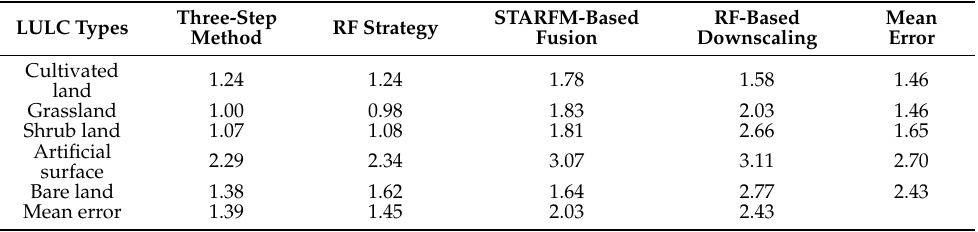
Table 5. Average distribution errors of the four predicted LST images at five land-cover types in Image B1 (K).